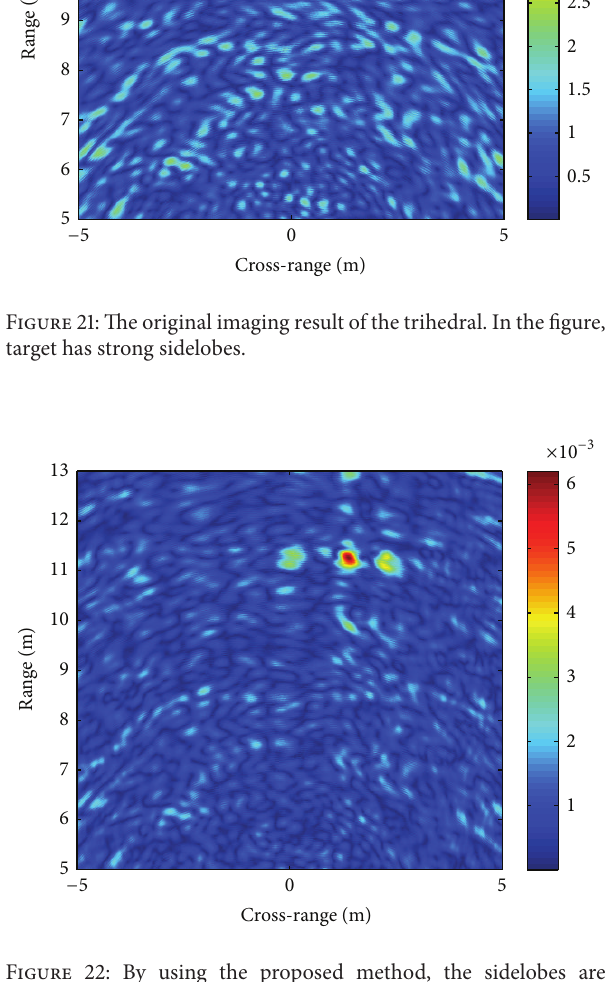
Figure 22: By using the proposed method, the sidelobes are